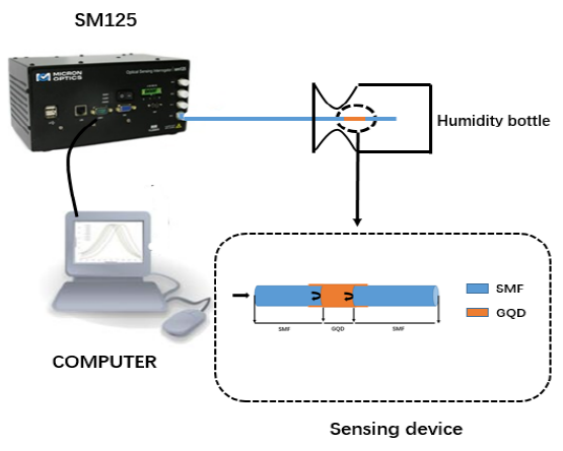
Figure 2. Experimental setup.